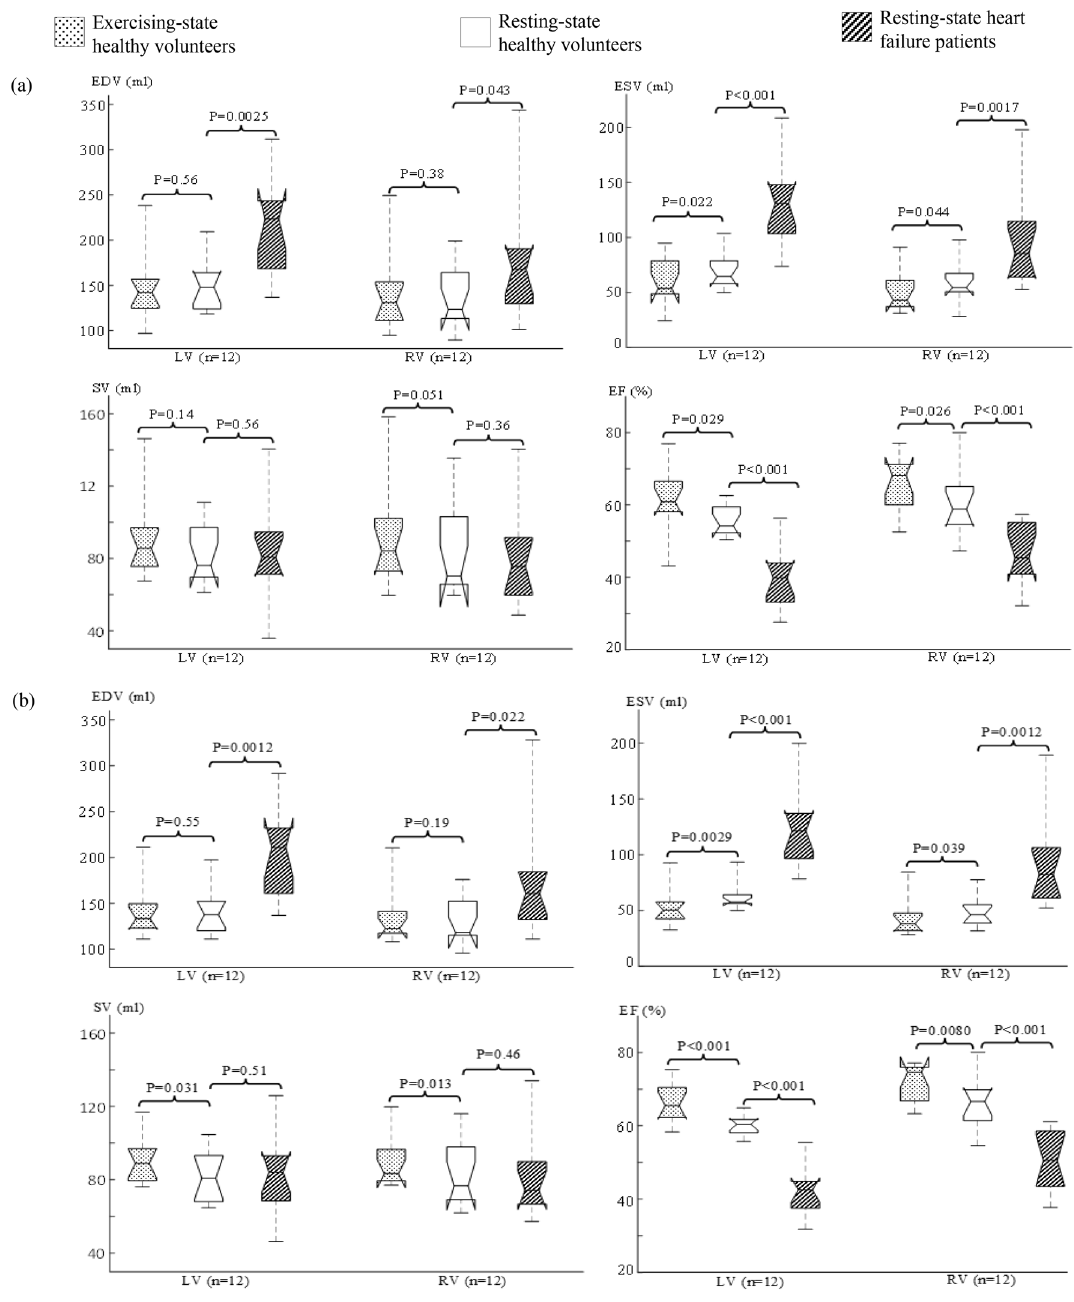
Figure 2. Box plots of the volumetric measurements with retrospective cine ( a ) and real-time imaging ( b ) in the healthy volunteers and HF patients. Each box provides the median, 25th and 75th percentiles of the measurements and the numbers give the t -test P values (n = or RV wall motion. Figure 4(a) provides examples of the correlation maps measured in the same subjects as in Fig. 1(a). The correlation was found to be globally higher in the healthy volunteer than that in the HF patient. Correspondingly, the HF patient gave lower spatial coherence. In each subject group, the normality of spatial coherence measurements was confirmed with an Anderson–Darling test (n = 12; P > 0.3). Figure 4(b) provides the t-test results for the comparison between different subject groups. The measurements of spatial coherence were found to be comparable during exercise and at rest in the healthy volunteers (0.53 ± 0.070 vs. 0.52 ± 0.039 for LV wall motion and 0.50 ± 0.068 vs. 0.50 ± 0.036 for RV wall motion, in arbitrary unit; n = 12; P > 0.4). In contrast, the HF patients presented significantly lower spatial coherence (0.38 ± 0.040 for LV wall motion and 0.35 ± 0.035 for RV wall motion, in arbitrary unit; n = 12; P < 0.001).